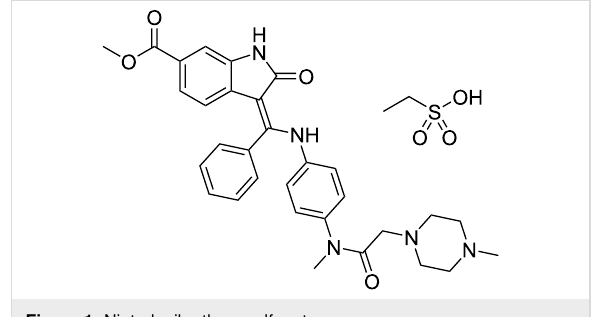
Figure 1: Nintedanib